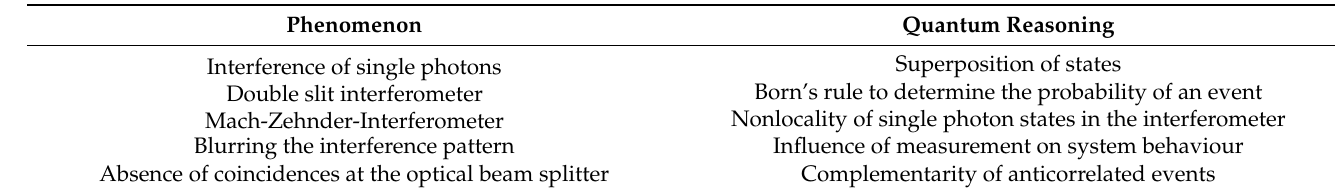
Table 1. Typical correspondence between quantum reasoning and quantum phenomena in hight school textbooks.